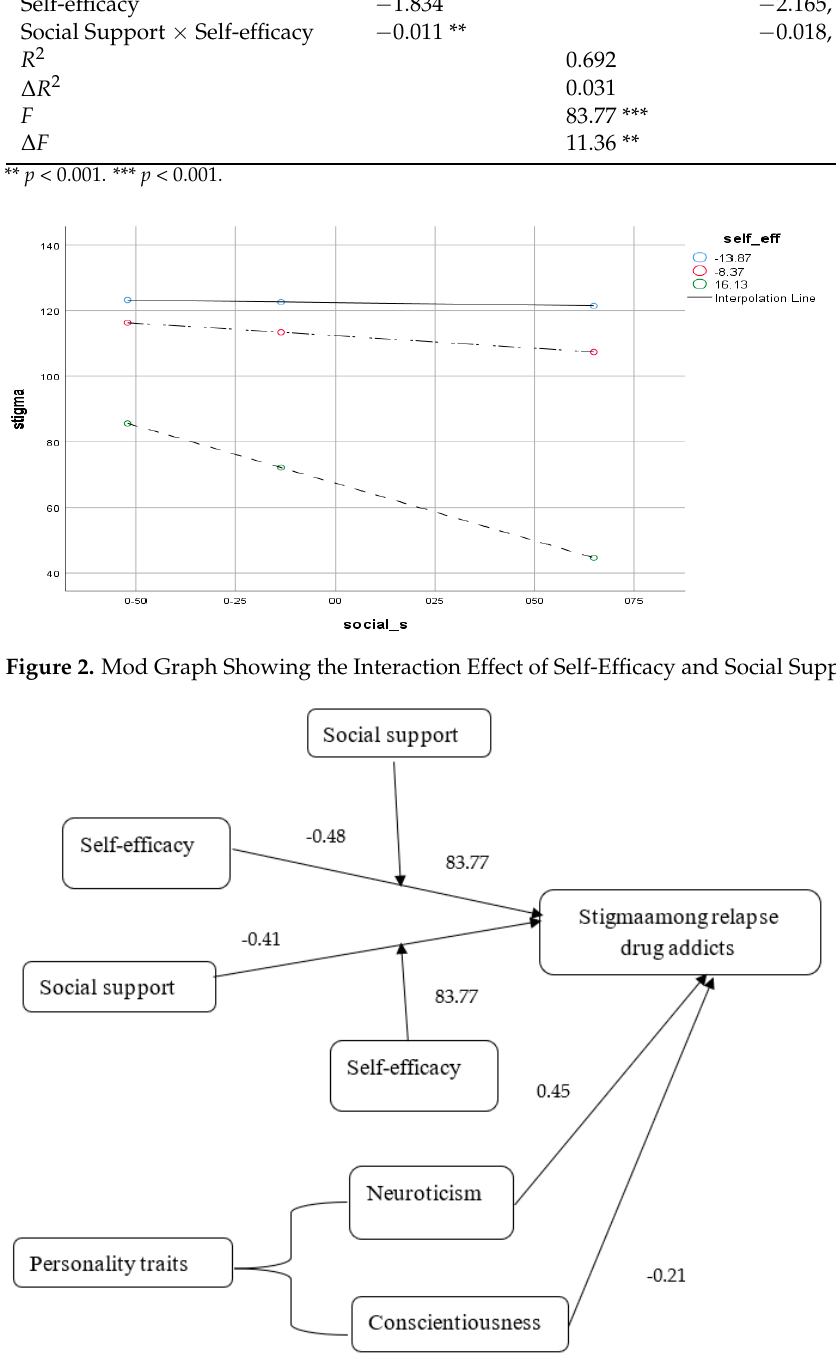
Figure 3. Outcome model of study